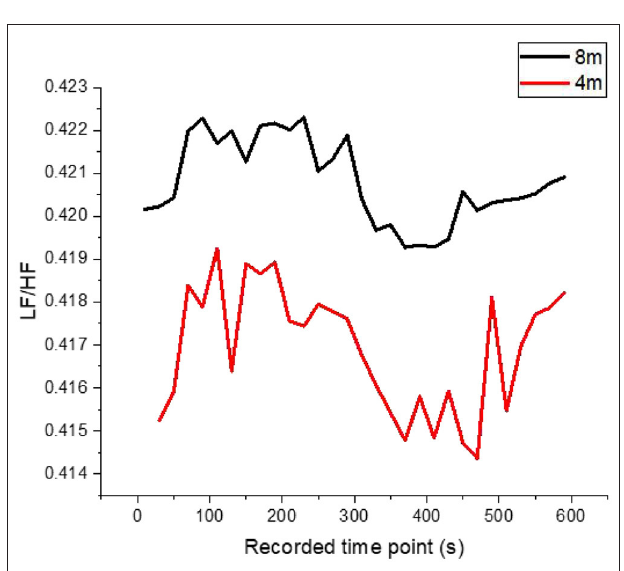
did not decrease obviously with the increase of setting density.